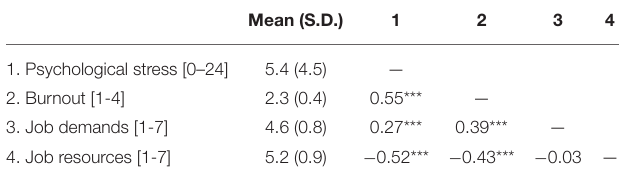
TABLE 1 | Descriptive statistics and correlations of key variables. Mean